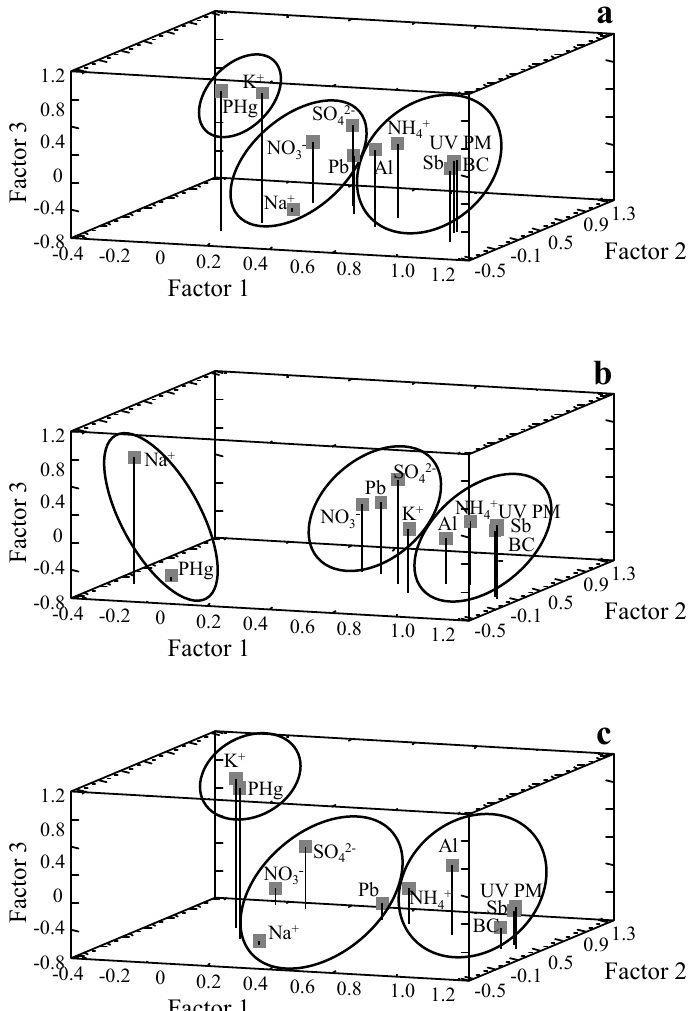
Figure 4. Three-dimensional plots of factor loadings for PM 10 mass, Na + , NH 4 + , SO 42 − , NO 3 − , Al, PHg, Pb, Sb, BC and UV PM contents at suburban site during one year long ( a ), summer ( b ) and winter ( c ) seasons.